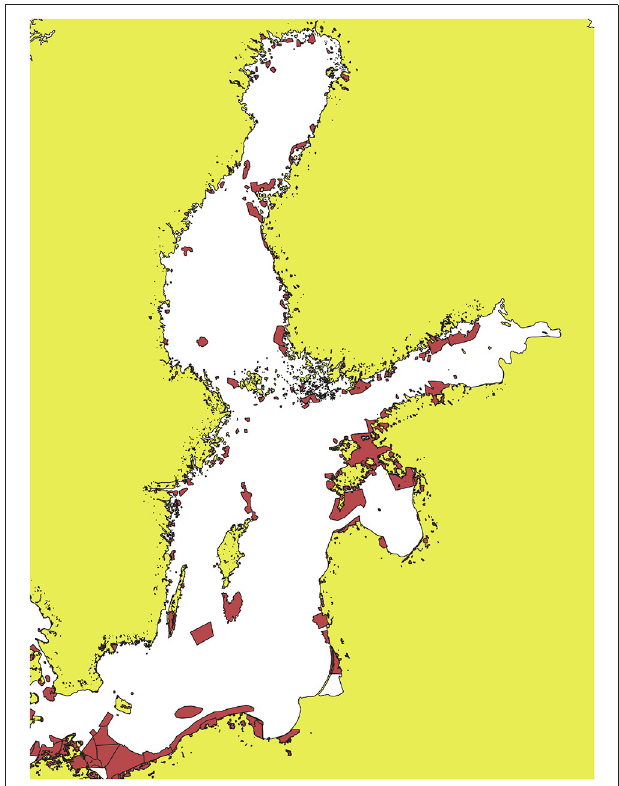
FIGURE 4 | Baltic region Natura2000 sites. Provided by HELCOM (2021).